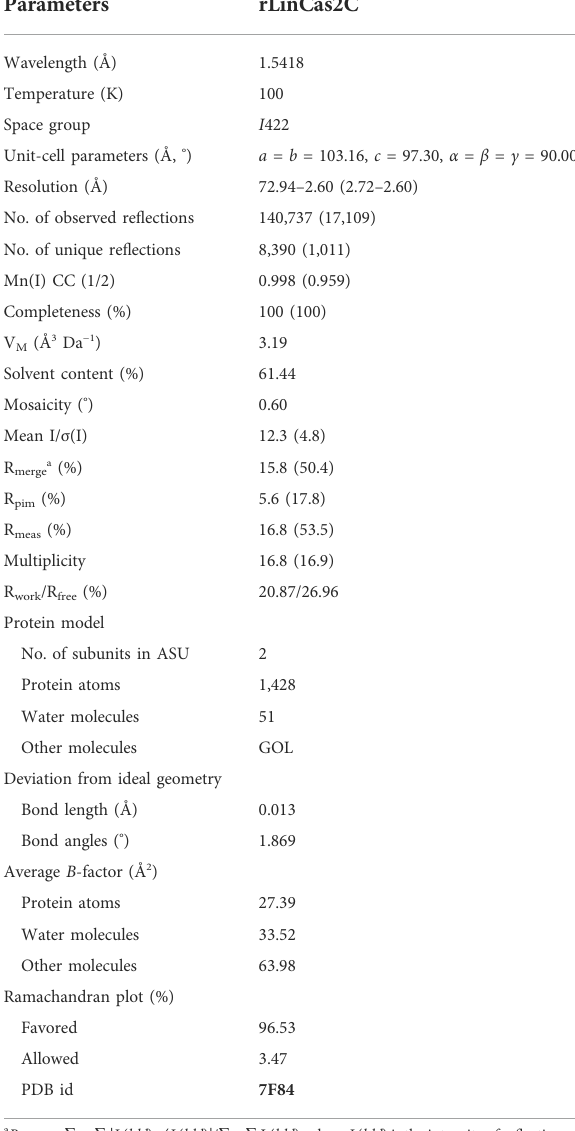
TABLE 1 Data collection and re fi nement statistics of rLinCas2C. The values in parenthesis are for the last resolution shell.